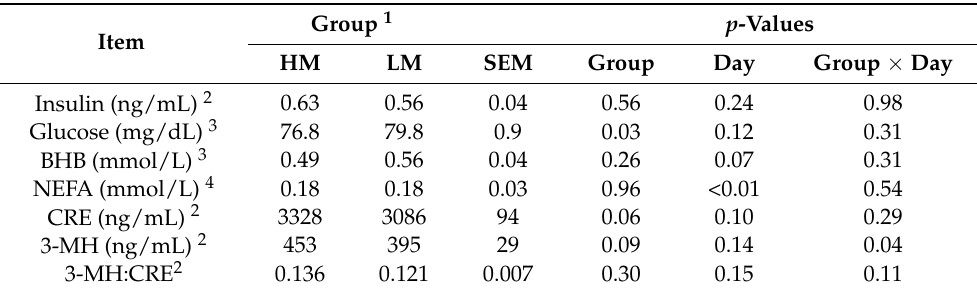
Table 3. Effect of high-muscle (HM; n = 20) and low-muscle (LM; n = 21) longissimus dorsi thickness (LDT) at 35 d before expected calving (BEC) on prepartum energy-related metabolites and hormone of insulin, glucose, β -hydroxybutyrate (BHB), non-esterified fatty acids (NEFA), creatinine (CRE), and 3-methyl histidine (3-MH).